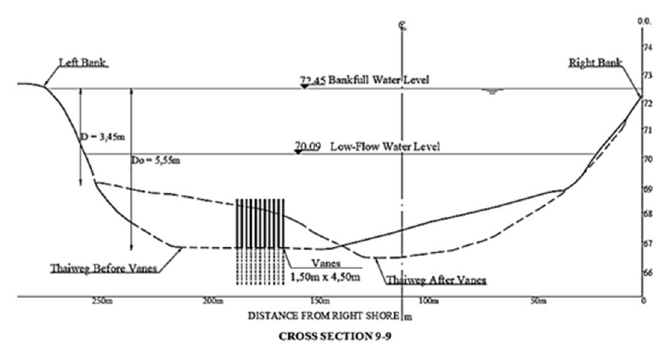
Figure 2. Cross section 9-9 used in the design of the vane field in front of the Aromatics dock.